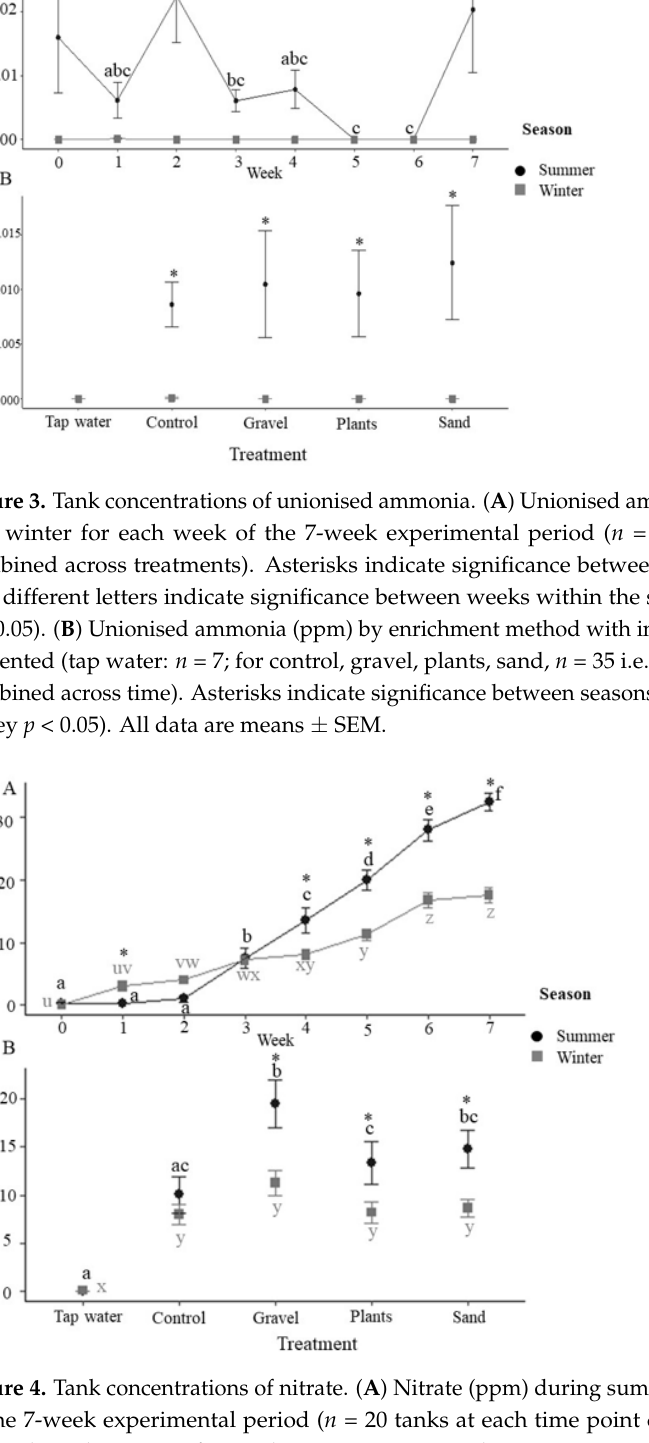
Figure 4. Tank concentrations of nitrate. ( A ) Nitrate (ppm) during summer and winter for each week of the 7-week experimental period ( n = 20 tanks at each time point combined across treatments). Asterisks indicate significance between seasons within a time point and different letters indicate significance between weeks within the same season (post-hoc Tukey p < 0.05). ( B ) Nitrate (ppm) by enrichment method with incoming tap water values also presented (tap water: n = 7; for control, gravel, plants, sand, n = 35 i.e., 5 tanks × 7 weeks with data combined across time). Asterisks indicate significance between seasons within a treatment and different letters indicate significance between treatments within the same season (post-hoc Tukey p < 0.05). All data are means ± SEM. Calcium concentrations in the water were significantly higher in the summer than in the winter (Figure 5A). Calcium concentrations were also affected by enrichment treat- ment, being higher with the gravel and sand enrichment than in the bare tanks and those with plastic plants as enrichment (Figure 5B). Calcium concentrations were lower in the incoming tap water than all the tanks.